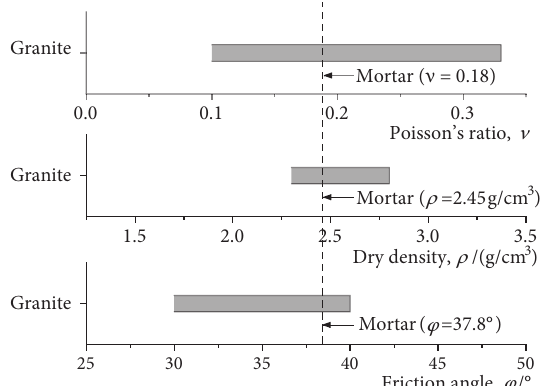
Figure 11: Triaxial compression test of rock-like material samples with preexisting crack.